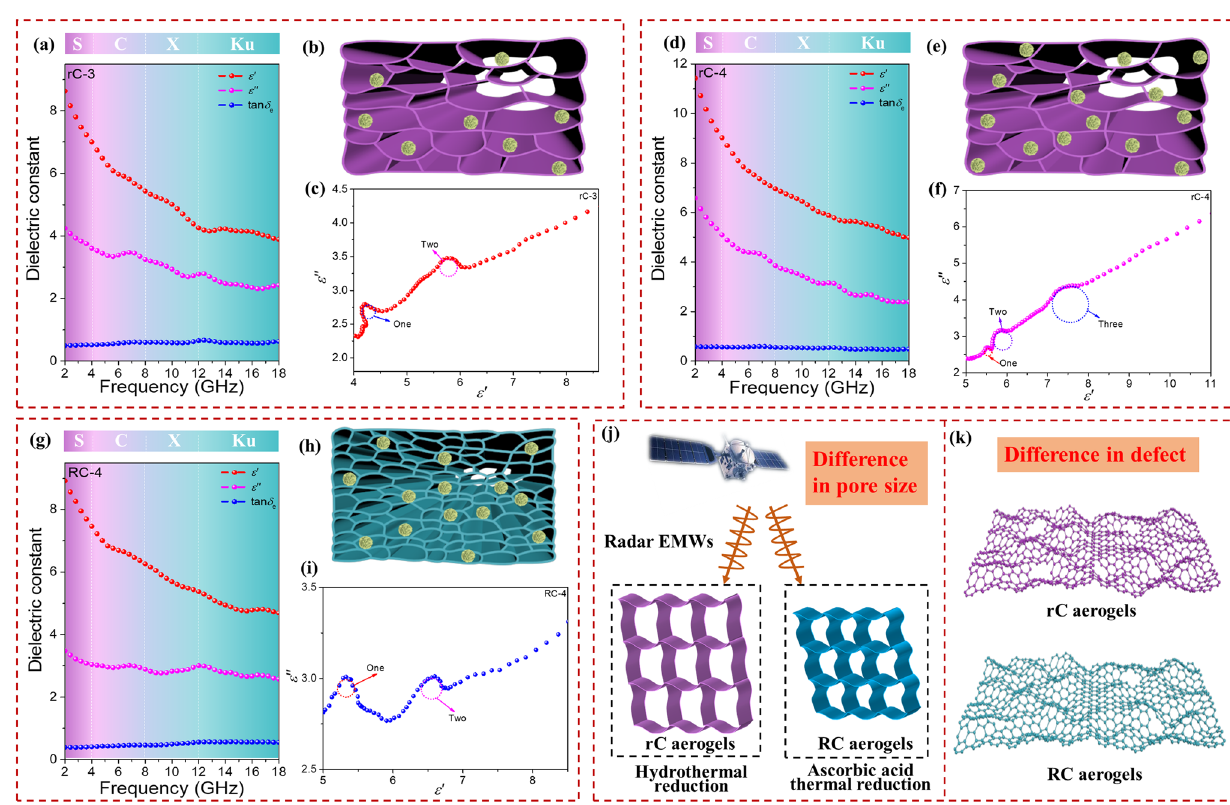
Fig. 4 𝜀 ′ , 𝜀 ′′ , tan δ e ~ f curves: a rC-3, d rC-4, and g RC-4. Structure diagram: b rC-3, e rC-4, and h RC-4. Cole–Cole curves: c rC-3, f rC-4, and i RC-4. Structure difference of rC and RC composite aerogels in j pore size and k number of